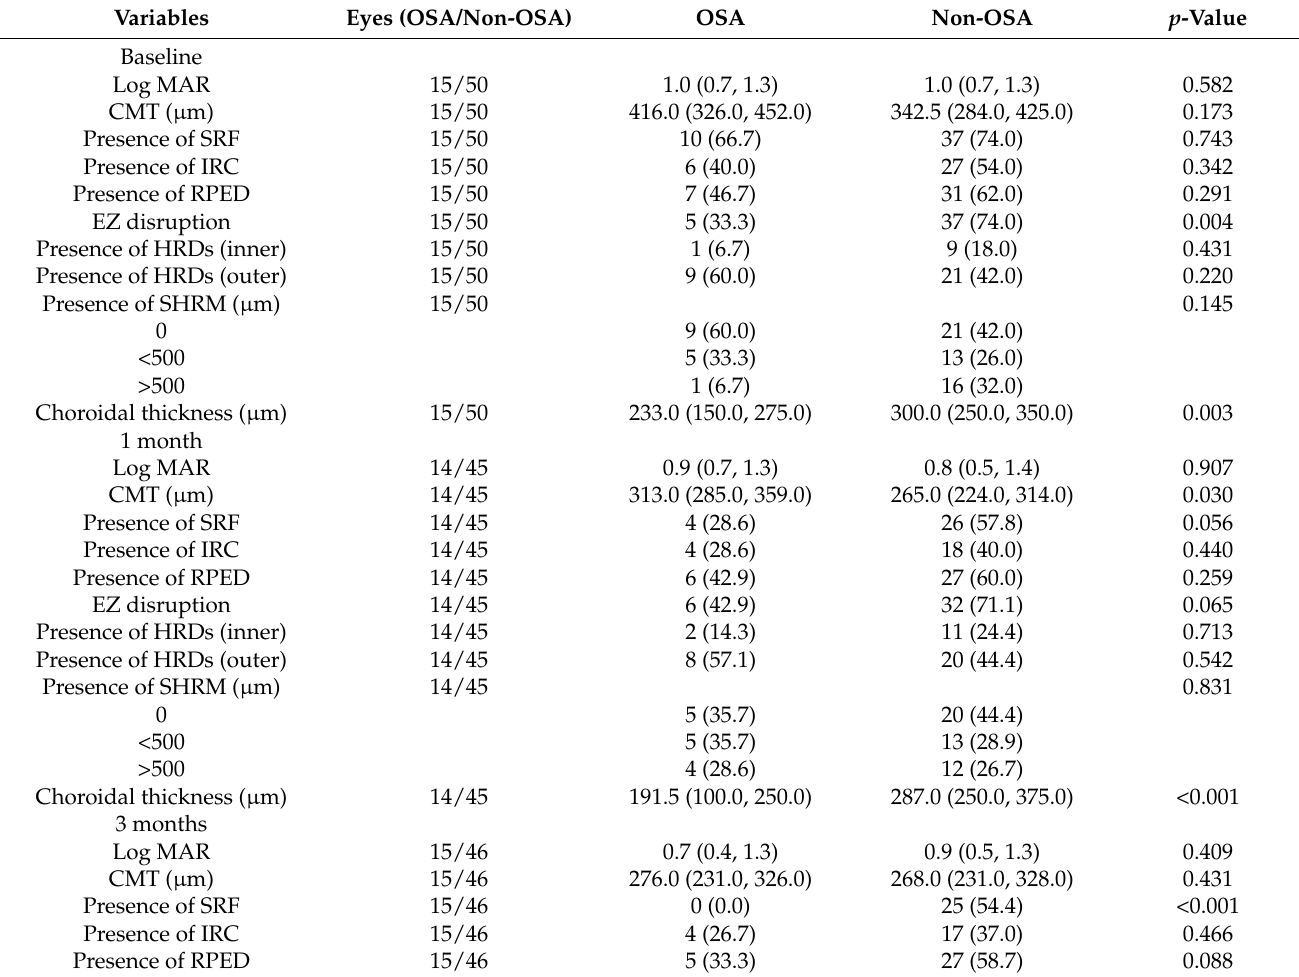
Table 2. Functional and anatomical outcomes at baseline and 1 and 3 months after anti-VEGF